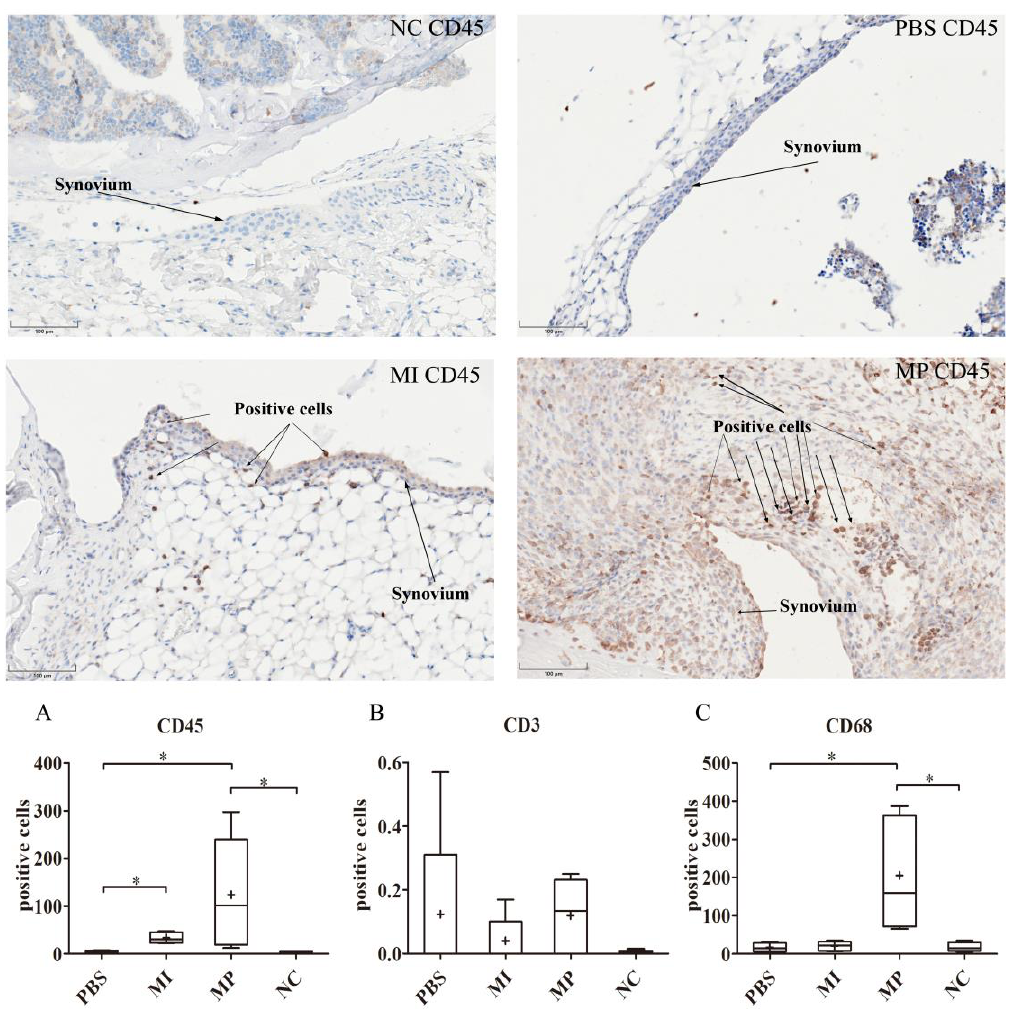
Figure 2. Expression of CD45, CD3 and CD68 in the synovial layer of left murine knees. The staining results of CD45 in the NC, PBS, MI and MP group. Numerous CD45 positive cells were found in the MP and MI group. MP and MI groups had significantly increased positive cells compared with the PBS group ( p < 0.05). ( A ) The expression of CD45 in the synovial layer of left murine knees. ( B ) The expression of CD3 in the synovial layer of left murine knees. No significant di ff erence was found in all groups. ( C ) The expression of CD68 in the synovial layer of left murine knees. (Magnification: 200x; * p < 0.05).